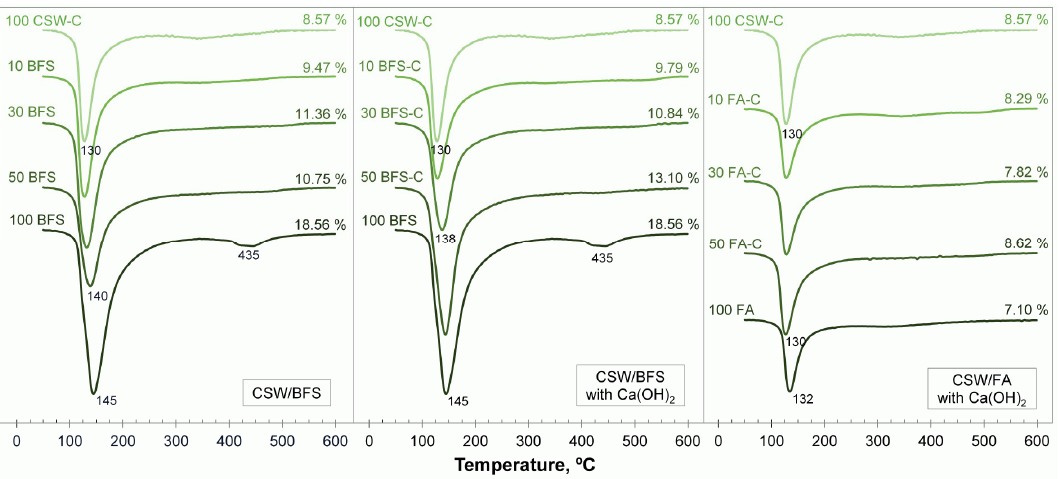
Figure 9. The differential thermogravimetric curves for the alkali-activated CSW blended pastes cured at 20 °C for 28 days. Total mass loss is indicated as a percentage.